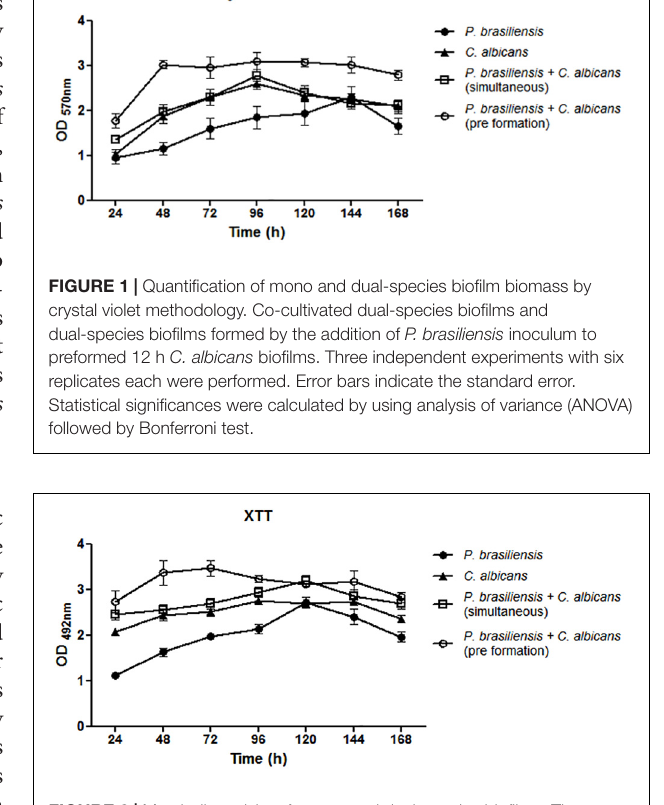
FIGURE 2 | Metabolic activity of mono- and dual-species biofilms. Three independent experiments with six replicates each were performed. Co-cultivated dual-species biofilms and dual-species biofilms formed by the addition of P. brasiliensis inoculum to preformed 12 h C. albicans biofilms. Error bars indicate the standard error. Statistical significances were calculated by using analysis of variance (ANOVA) followed by Bonferroni test.